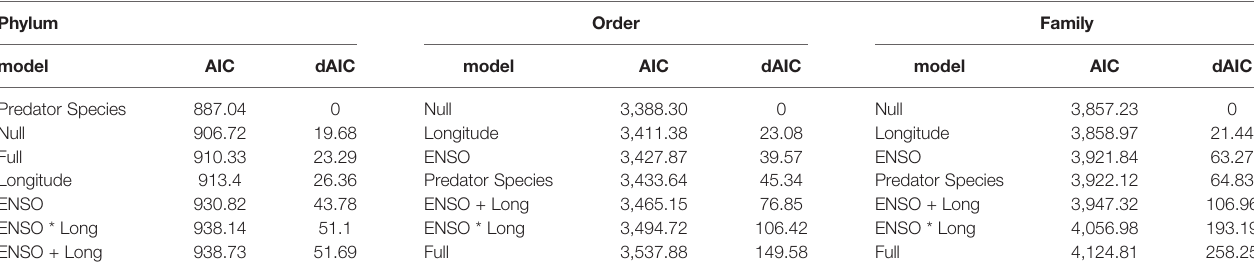
TABLE 4 | Generalised linear model analyses used to explain differences in gut microbiome composition to the Phylum, Order and Family level in Katsuwonus pelamis and Thunnus pelamis captured in the Paci fi c during El Niño Southern Oscillation events (ENSO). Phylum Order Family model Predator